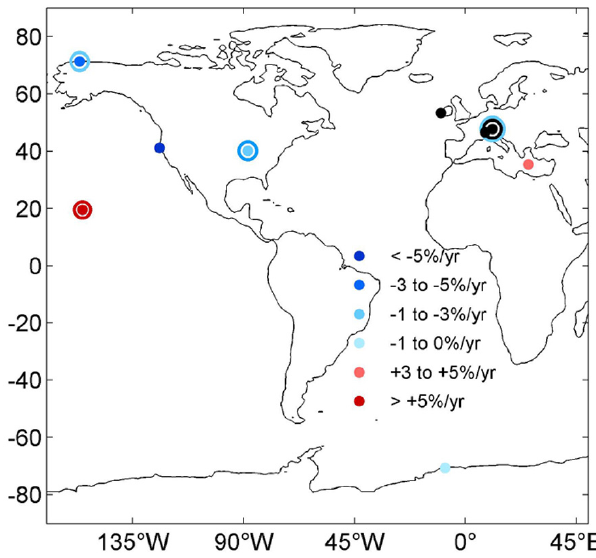
Fig. 6. Mann-Kendall trend results for the absorption coefficient. The symbols have the same meaning as in Fig.